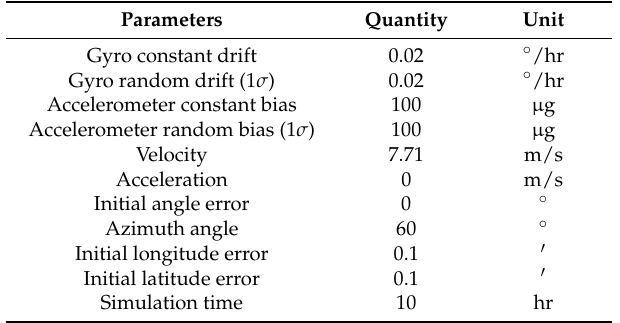
Table 1. Simulation conditions of the inertial navigation system